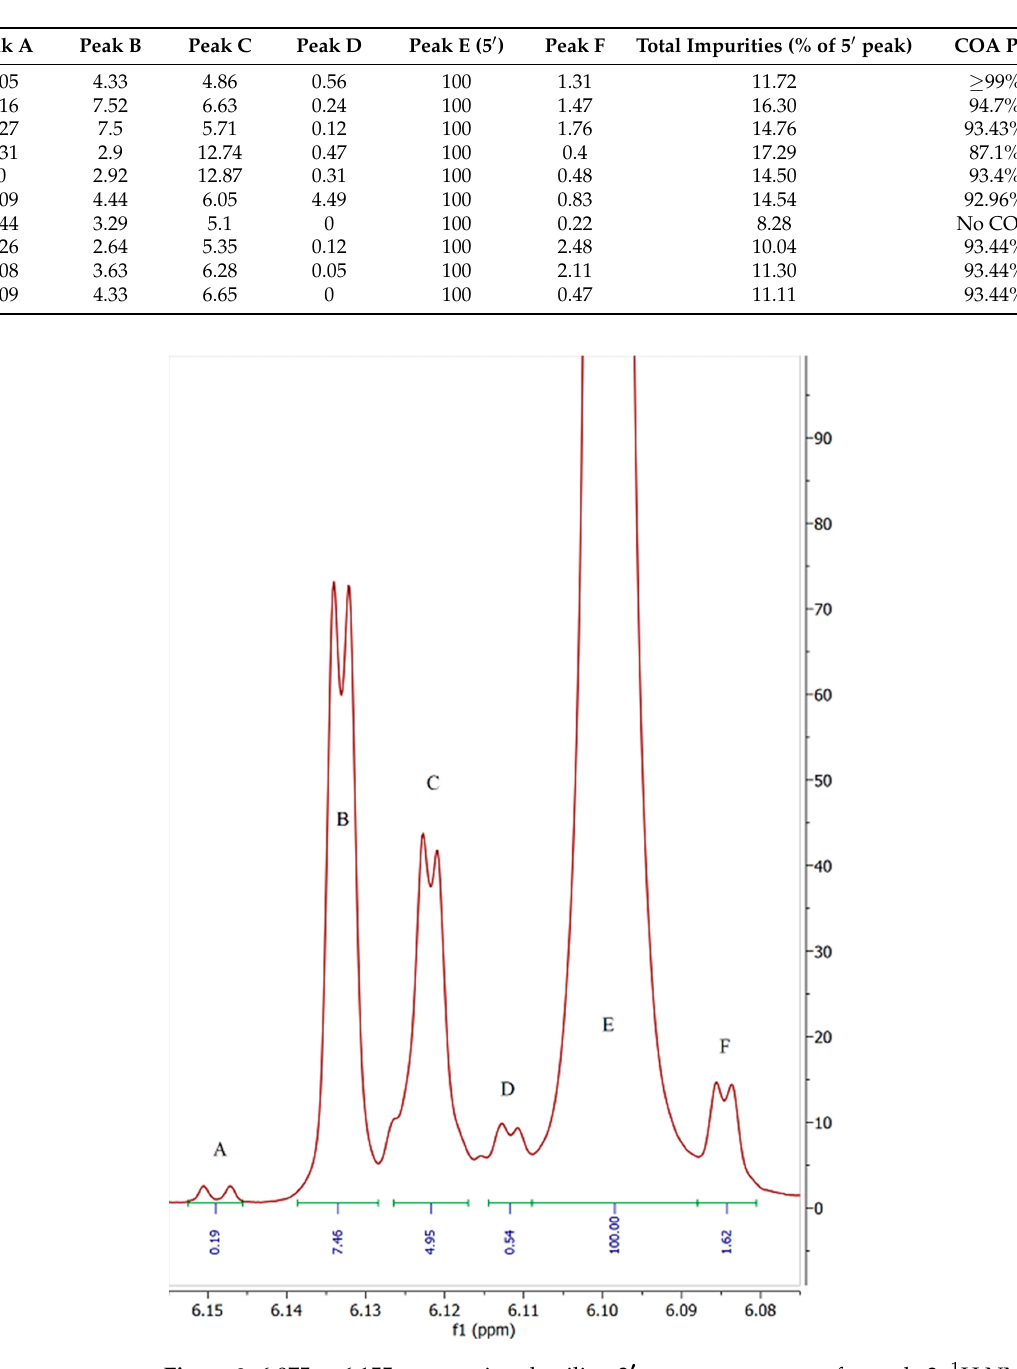
Figure 3. 6.075 to 6.155 ppm region detailing 3 ′ proton resonance of sample 3. 1 H NMR (800 MHz, CDCl 3 ) δ 6.15 (d, J = 2.7 Hz), 6.13 (d, J = 1.6 Hz), 6.12 (d, J = 1.6 Hz), 6.11 (d, J = 1.7 Hz), 6.10 (d, J =